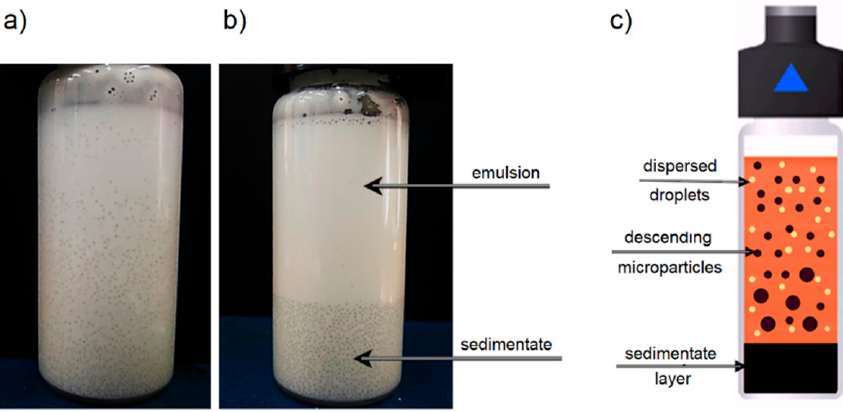
Figure 1. Photo of emulsion with glass microspheres—( a ) just after preparation, ( b ) after 1800 s, and ( c ) scheme of the system.